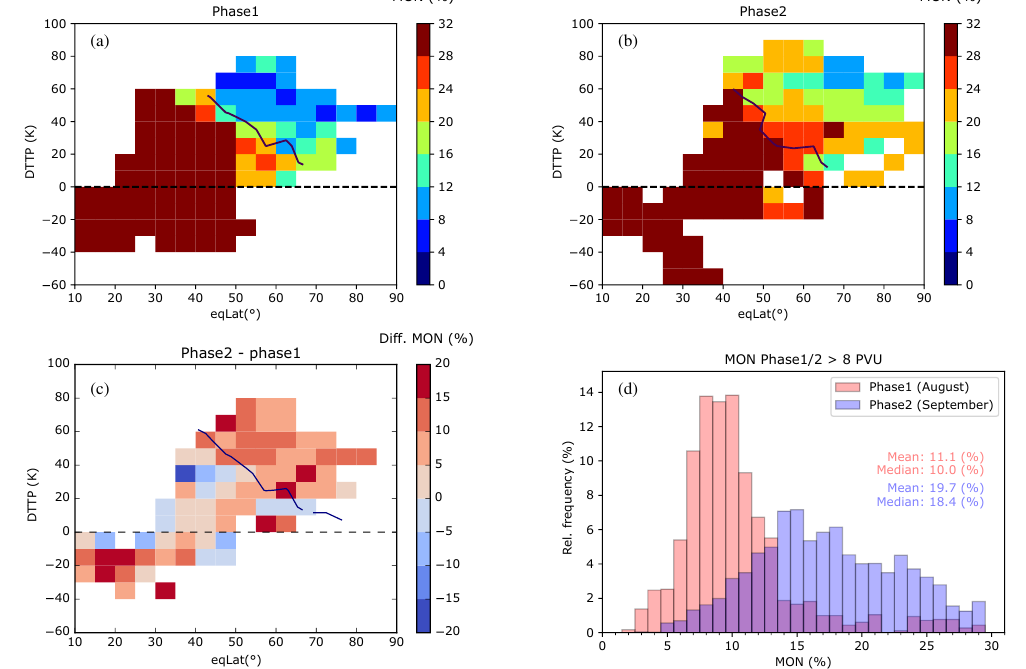
Figure 3. Same as Fig. 2 but for the simulated Asian monsoon surface tracer